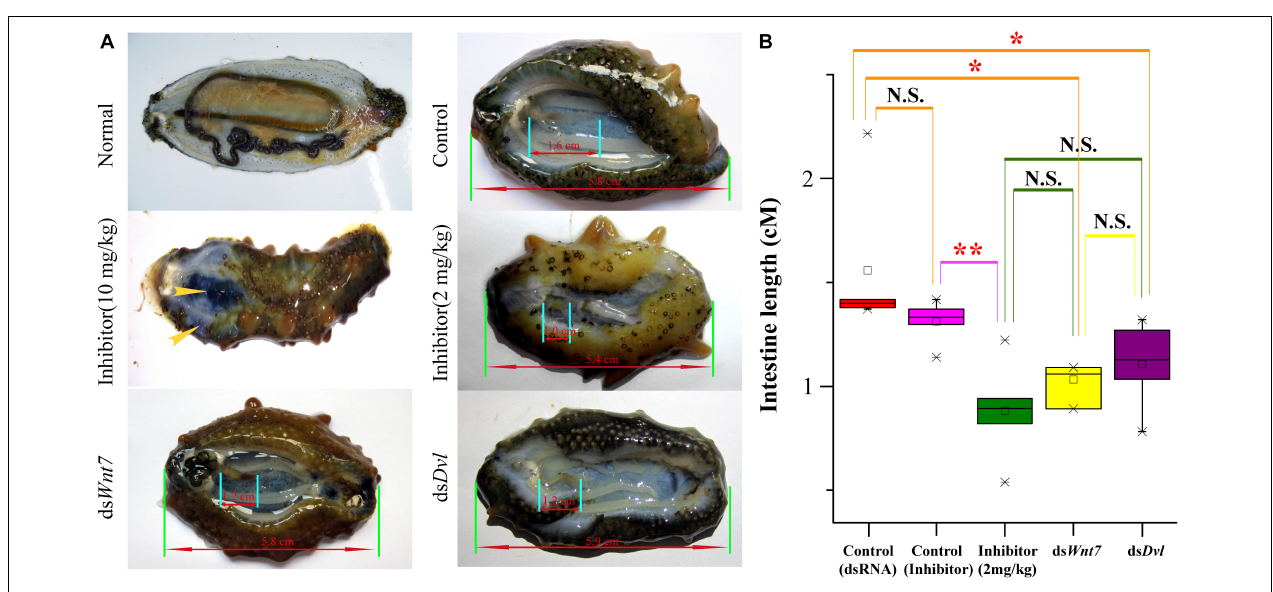
in comparison to that injection of ds EGFP , suggesting Wnt7 and Dvl were functional important in intestinal regeneration ( Figure 7